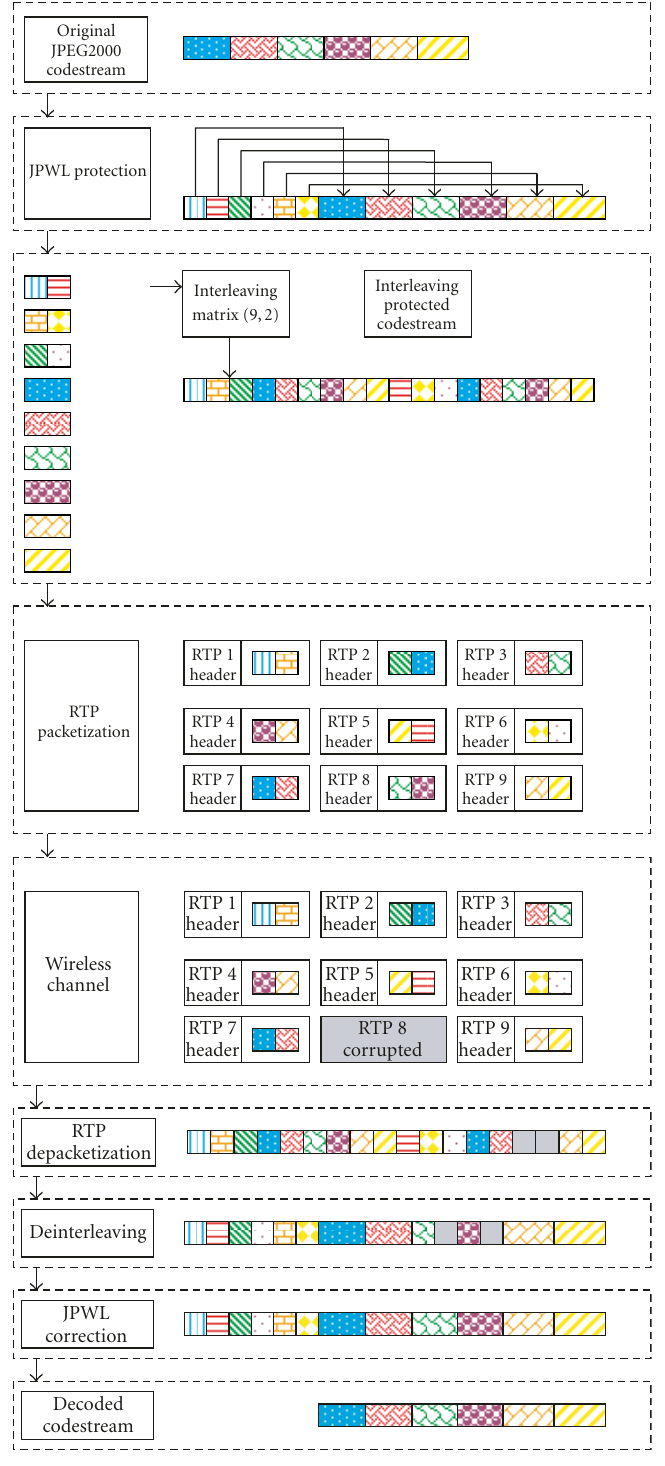
Figure 3: JPEG 2000 codestreams transmission through the proposed JPWL